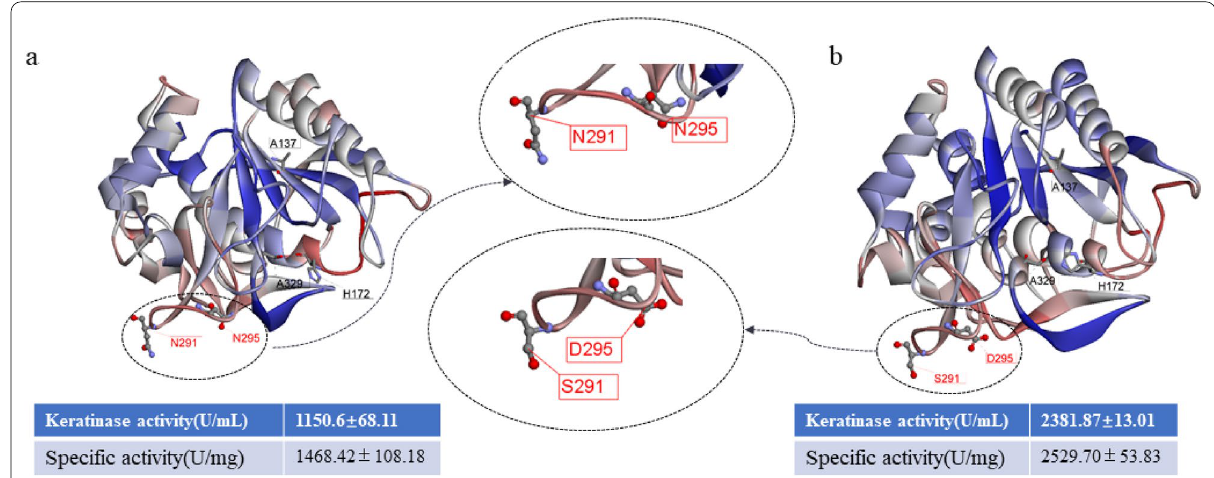
Fig. 3 Three‑dimensional structural model by homology modeling. a KerBp. b Variant